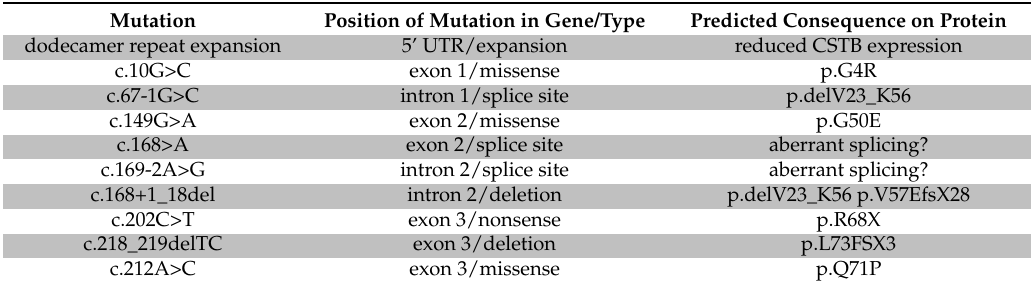
Table 1. Mutations in CSTB underlying Unverricht–Lundborg disease (EPM1)